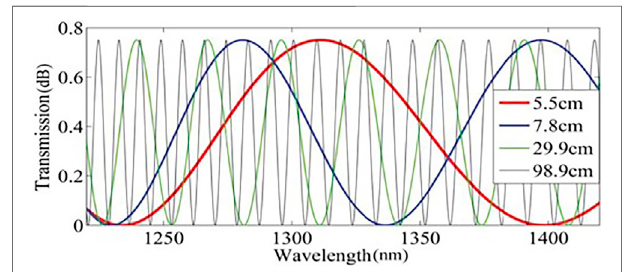
FIGURE 10 | Simulate spectrum when L is 5.5 cm (Red), 7.8 cm (Blue), 29.9cm (Green) and 98.9 cm (Black). [44]